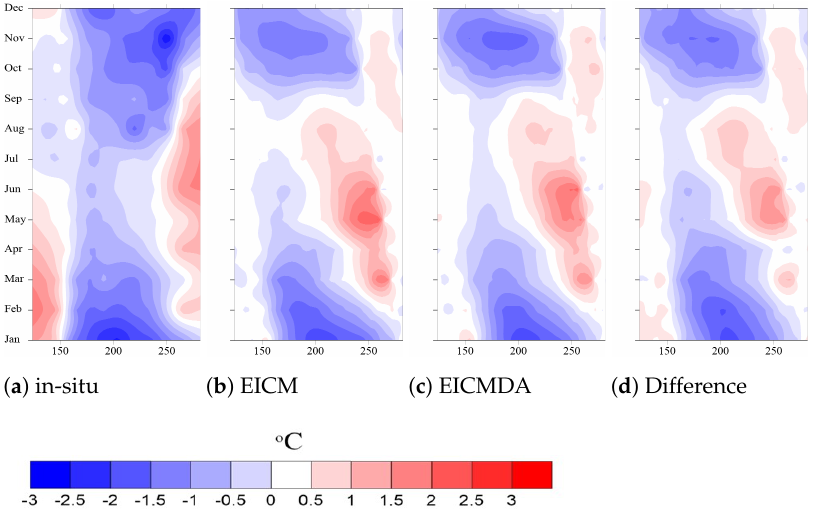
Figure 7. Observed and predicted SSTA ( ◦ C) evolutions along the equator.